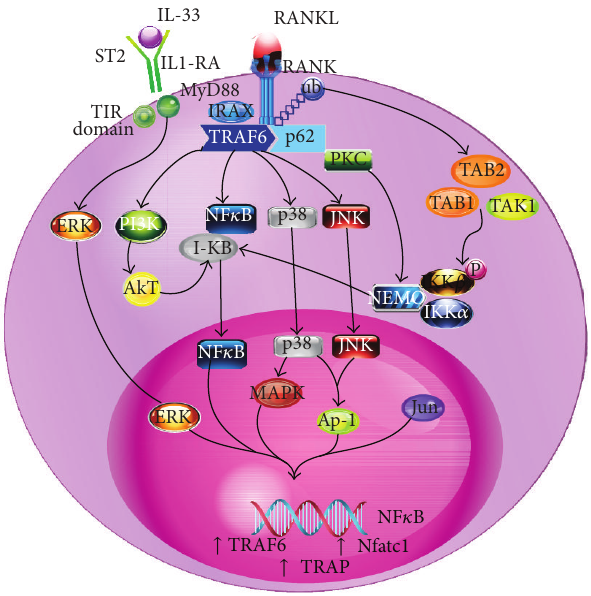
Figure 1: RANKL-independent signalization pathways of IL-33 and RANKL signaling in circulating monocytes. Binding of IL-33 to its receptor, ST2, leads to recruitment of MyD88 that phosphorylates ERK, activating important factors in the terminal differentiation of osteoclast as TRAF6, NFATc1, and TRAP. Activation of RANK by RANKL induces the recruitment of TRAF6, leading to the phosphorylation of PI3K, p38, and JNK. Upregulation of p62 activates PKC degrading TAB2 by ubiquitin-proteasome complex. PI3K activates AkT that phosphorylate the inhibitory IkB that is degraded by the proteasome, liberating active NFKB. The degradation of TAB2 leads to TAK1 liberationandPKCactivationbyp62that,inturn,inducethephosphorylationofNEMO,liberatingactiveNFKB.Thismoleculetranslocatesto the nucleus inducing gene transcription and contributes to the activation o NFATc1. PI3K and P38 activate AP-1 that translocate to the nucleus forming a complex with NFATc1 to activate osteoclast-specific genes. The RANKL and IL-33 signalization activate intersecting downstream effectors,suchasTRAF6,PI3K,JNK,andprincipallyNFKB.Activatorprotein-1(AP-1);extracellularsignal-regulatedkinases(ERK);inhibitor of kB (IKB); interleukin-33 (IL-33); interleukin 1 receptor antagonist (IL1-RA); interleukin-1 receptor-associated kinase 1 (IRAK); I 𝜅 B kinase (IKK); c-Jun N-terminal kinases (JNK); protein kinase C (PKC); mitogen-activated protein kinases (MAPK); myeloid differentiation primary response gene (MyD); nuclear factor of activated T cells (NFAT); nuclear factor kappa B cells (NFKB); receptor activator of NFKB (RANK); receptor activator of NFKB ligand (RANK-L); TAK-1-binding protein (TAB); TNF receptor associated factors (TRAF); phosphatidylinositol 3-kinases (PI3K); serine/threonine kinase (AKT); regulatory subunit NFKB-essential modulator (NEMO); tartrate-resistant acid phosphatase (TRAP); Toll-interleukin receptor (TIR); transforming growth factor- 𝛽 activated kinase (TAK); ubiquitin